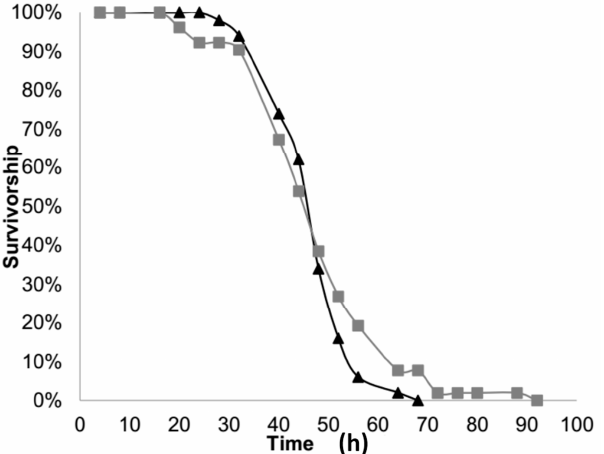
Figure 1. Percent of neonates surviving over time without food; triangles representing newly-hatched larvae (completely-starved) and squares representing larvae that had access to food for 24 h before starvation (partially-starved).